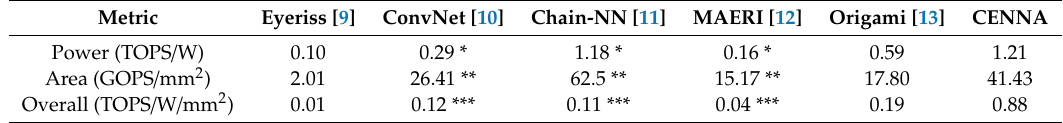
Table 9. E ffi ciency comparison with the state-of-the-art